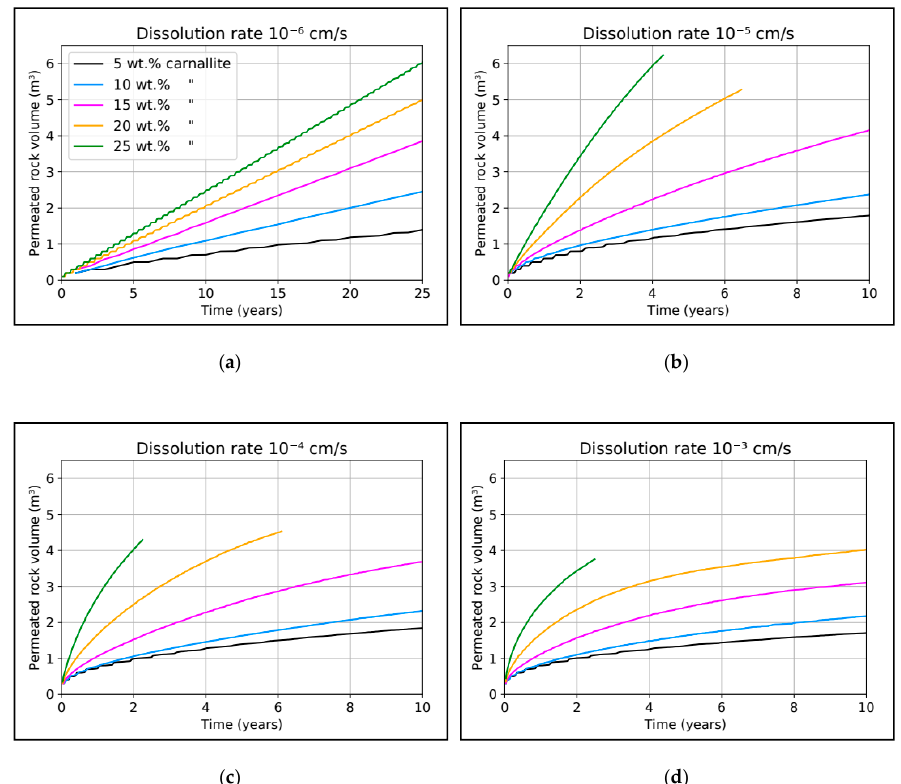
Figure 7. Comparison of the permeated rock volume over time for different dissolution rates ( a – d ) and carnallite contents (line colour) of the modelled potash seam. Curves that end before a simulation time of 10 years indicate the leaching zone arrival at the right model boundary.